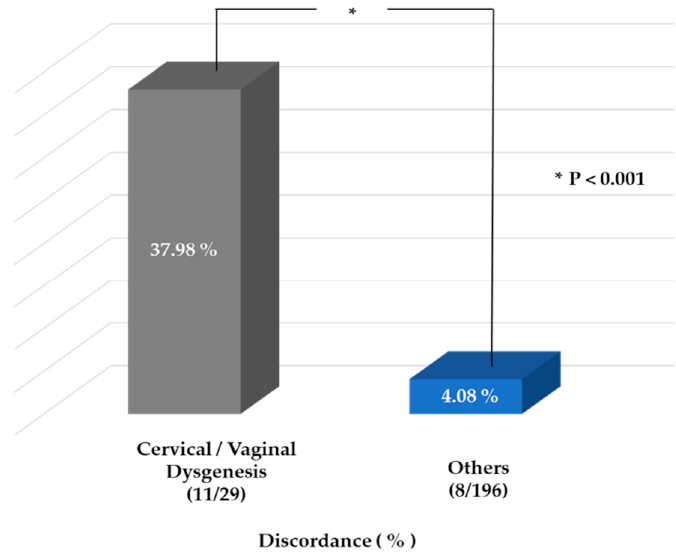
Figure 1. A graph of the discordance between the magnetic resonance imaging-based diagnosis and the final diagnosis in patients with genital tract anomalies (* p < 0.001, chi-square test). For example, in Patient 15, preoperative MR images showed a clear cervical contour and were assumed to represent vaginal stenosis with a presumed hematocolpos (hema- toma in vagina); therefore, a vaginoplasty for vaginal agenesis was planned (Figure 2). However, an intraoperative tissue biopsy at the caudal edge of the hematoma lesion, pro- ducing presumptive vaginal tissue, revealed the presence of cervical gland and stroma material. Therefore, the final diagnosis of the case was changed to cervical dysgenesis ac- companied with vaginal agenesis. In addition, diagnostic hysteroscopy showed no re- sistance when the telescope entered the uterus-like lesion, in which this surgical finding also supported the final diagnosis, cervical dysgenesis accompanied with vaginal agene- sis. Figure 2. The sagittal T2-weighted magnetic resonance image shows a definite contour of the cer- vix (arrowhead), suggesting vaginal agenesis with fluid collection in Patient 15 (Table 2). How- ever, the intraoperative biopsy, which was performed at the caudal leading edge (arrow), revealed the presence of cervical gland and stroma material. 4. Discussion